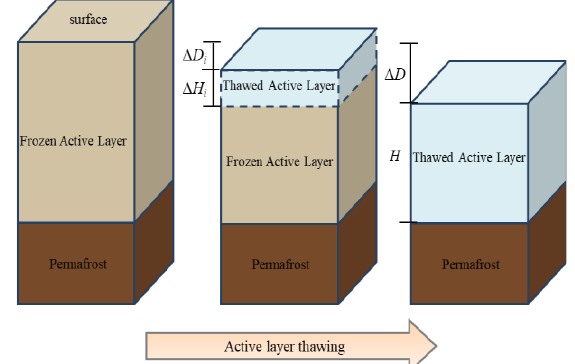
Figure 1. Active layer thawing process (diagrams are not to scale), modified from (Liu et al., 2012)